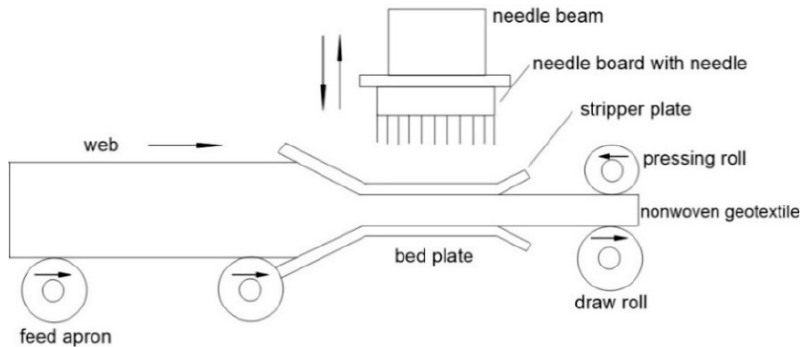
Figure 3. Scheme of needle-punching process (adapted from [12]).